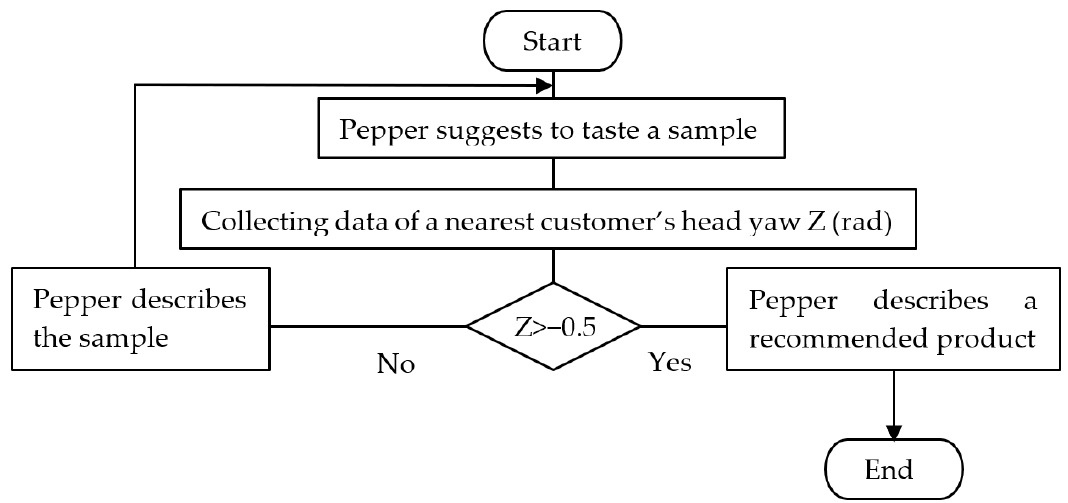
Figure 12. Function of automatic description of products after robot’s suggestion.